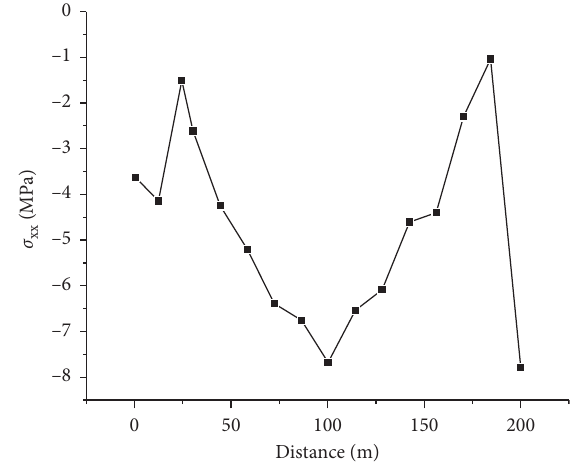
Figure 10: The horizontal stress of monitoring points in the third left working face.